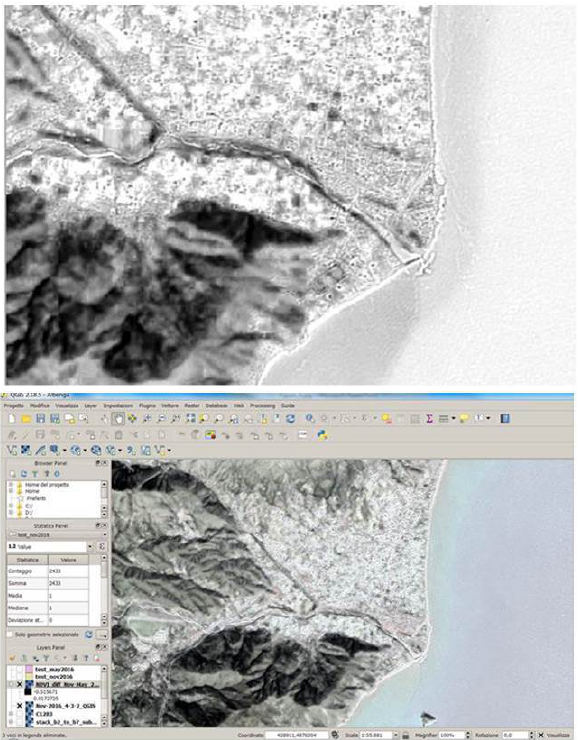
Figure 6 NDVI difference between May and Nov 2016 (above); NDVI difference superimposed to the RGB composite of the LS-8 image taken on Nov 29 th 2016.